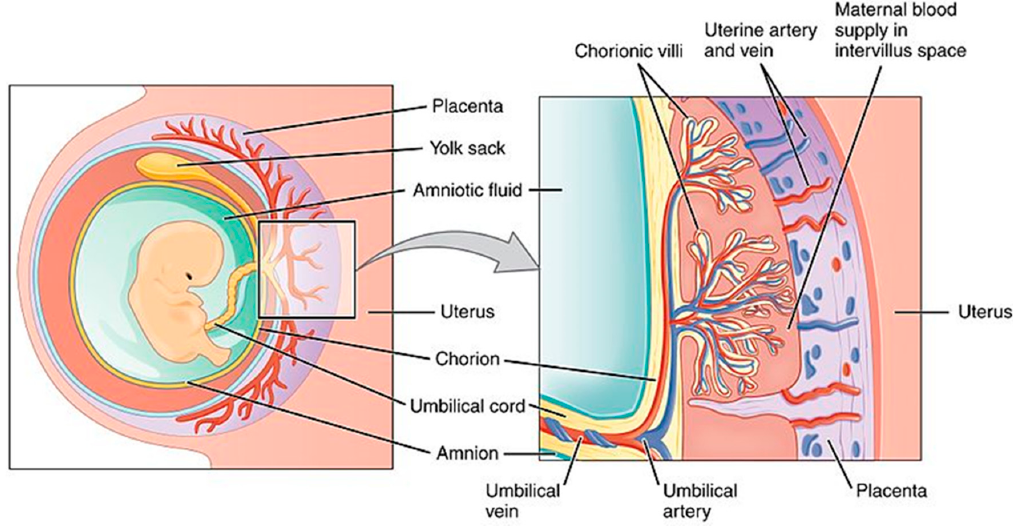
Figure 1. Schematic view of the placenta. Source: Anatomy & Physiology.